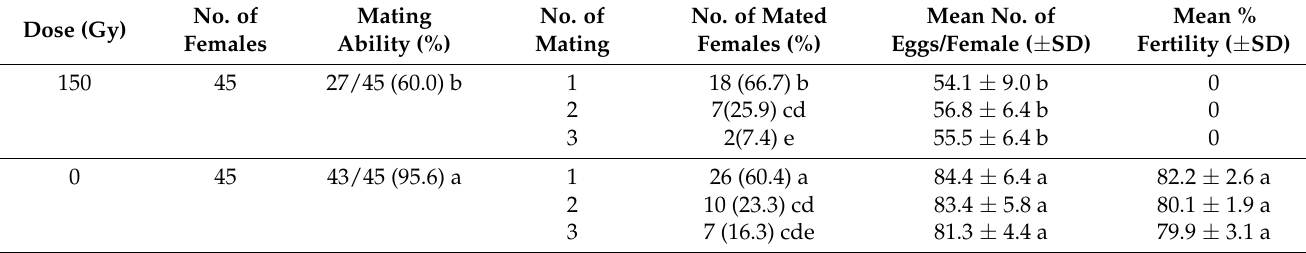
Percentages in columns followed by the same letters are not significantly different ( p < 0.05, normal approximation test). Means in columns followed by the same letters are not significantly different ( p < 0.05, Fisher PLSD).